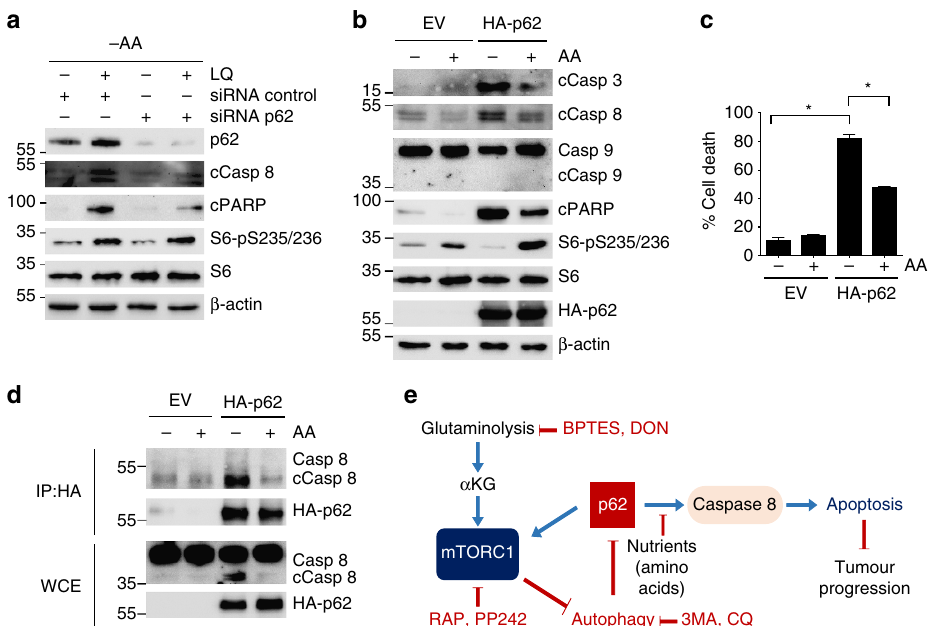
Figure 6 | p62 interacts with and activates caspase 8 and apoptosis. ( a ) U2OS cells were transfected either with a non-targeting siRNA (control) or siRNA against p62. Then cells were treated with LQ for 72h. The activation of apoptotic markers and mTORC1 downstream targets were assessed by western blot analysis. ( b , c ) U2OS cells were transfected with HA-p62 for 24h and then incubated in the presence or the absence of all the amino acids for 48h as indicated. The expression of apoptotic markers and mTORC1 downstream targets were assessed by western blot ( b ), and cell viability was estimated using trypan blue exclusion assay ( c ). Graphs show mean values ± s.e.m. ( n ¼ 3). * P o 0.05 (Anova post hoc Bonferroni). ( d ) U2OS cells were transfected with HA-p62 and the interaction of HA-p62 with endogenous caspase 8 was evaluated by immunoprecipitation upon amino acid starvation ( (cid:2) AA) or amino acid sufficiency ( þ AA). The co-precipitation of bot HA-p62 and caspase 8 was determined by western blot analysis. ( e ) Working model summarizing the results obtained in this